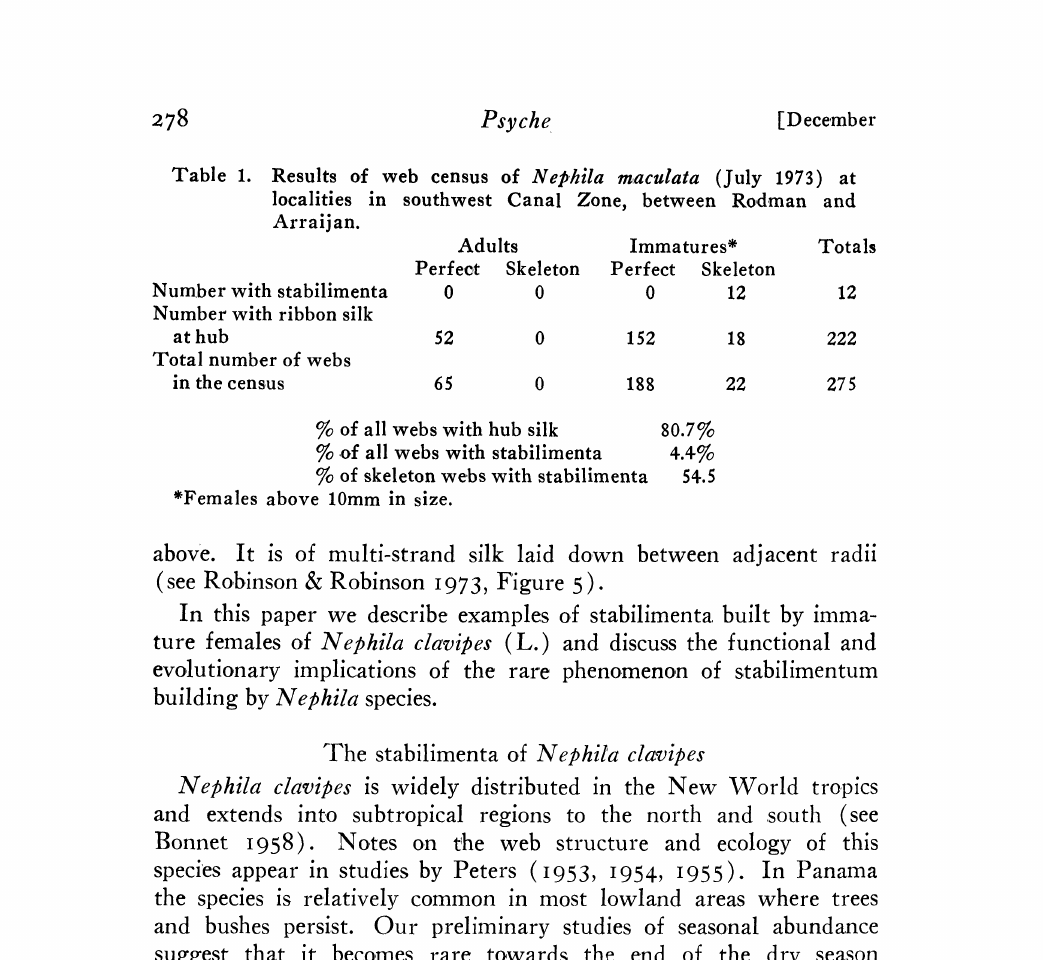
Table 1. Results of web census of Nephila maculata (July 1973) at localities in southwest Canal Zone, between Ro,dman and Arraijan. Adults Immatures* Perfect Skeleton Perfect Skeleton Number with stabilimenta 0 0 0 12 12 Number with ribbon silk athub 52 0 152 18 222 Total number of webs 65 0 188 22 275